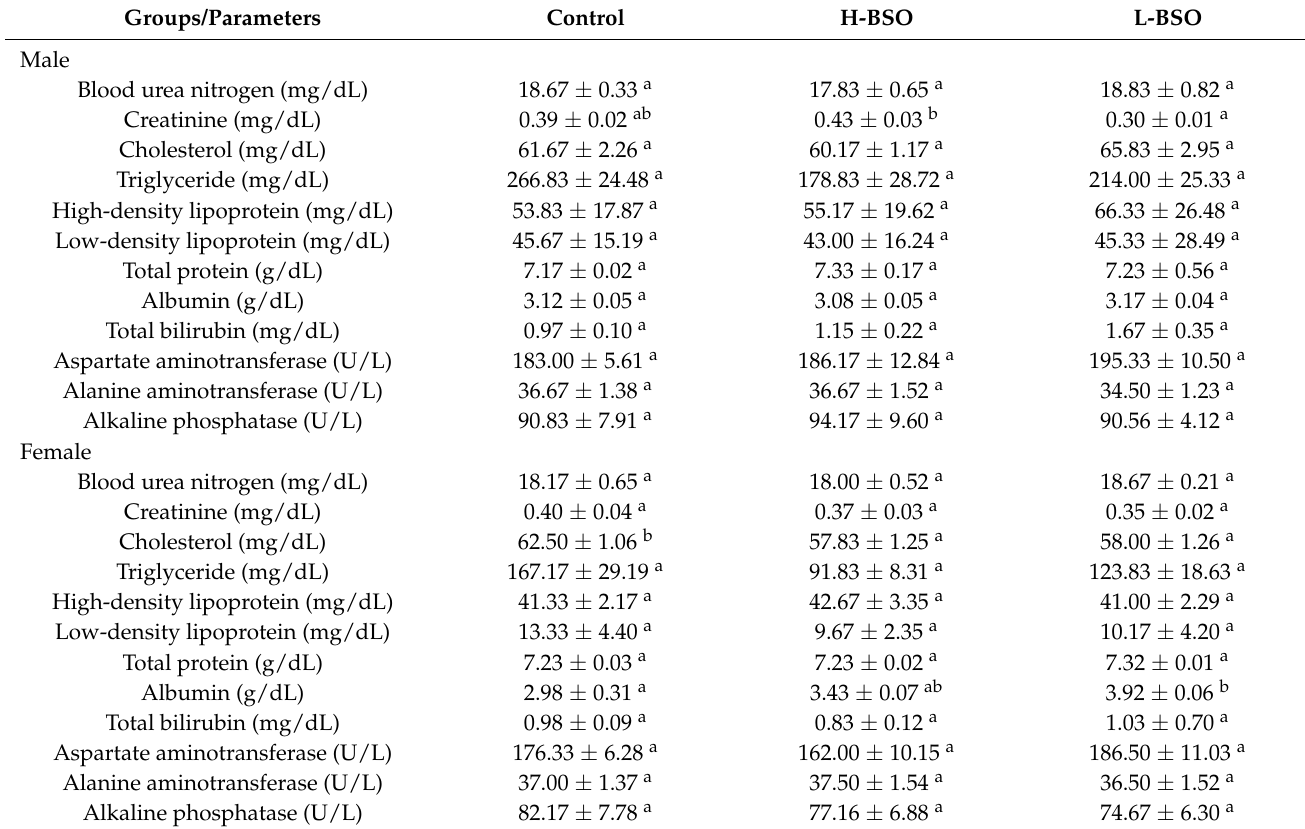
Table 4. Biochemical parameters of male and female rats treated with BSO for 28 days.